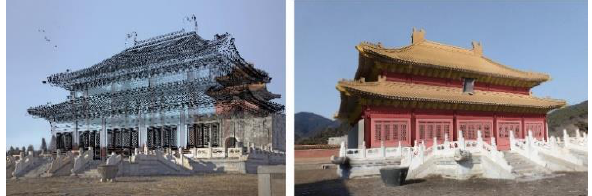
Figure 2. The restoration design of